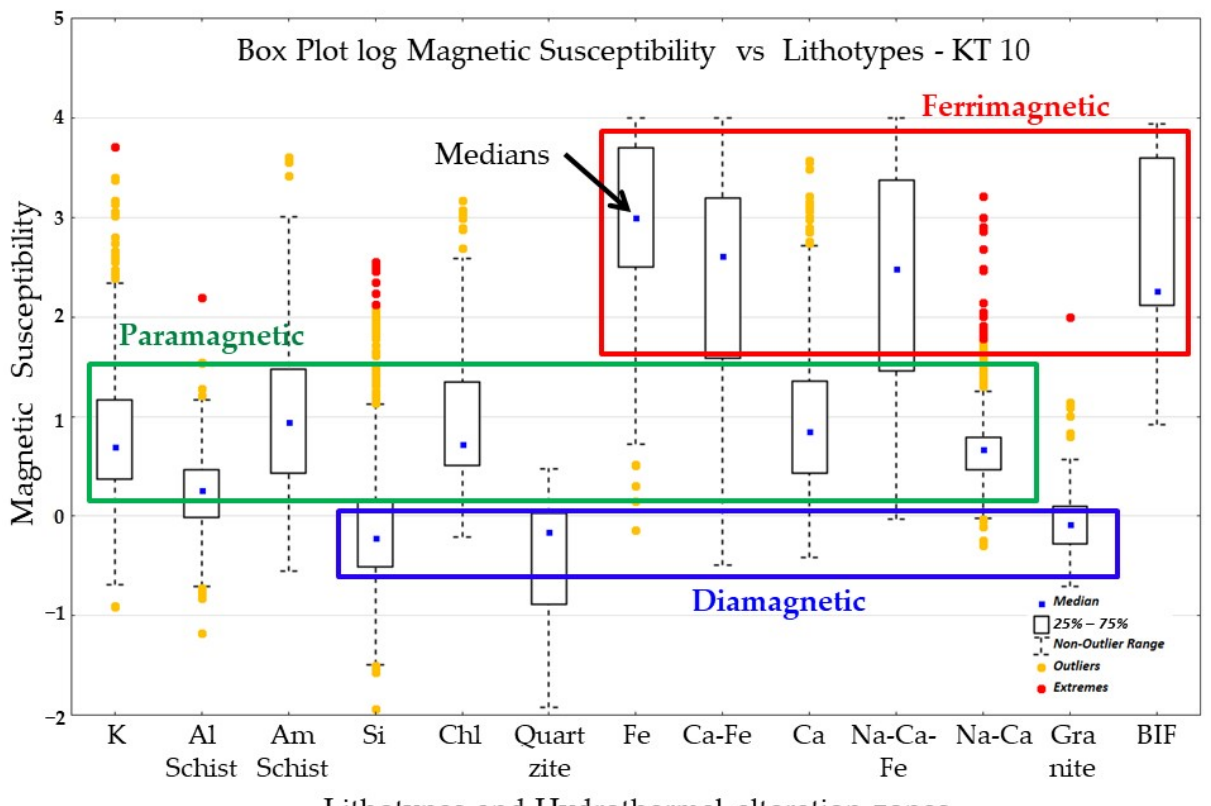
Figure 18. Box plot log of magnetic susceptibility (SI) versus lithotypes with values from the higher sensitivity susceptibility meter (KT-10). The ferrimagnetic, paramagnetic, and diamagnetic minerals dominances is represented in red, green, and blue rectangles, respectively. K = potassic, Al = aluminous, Am = amphibolitic, Si = silicification, Chl = chloritization, Fe = ferric, Ca = calcic, Na = sodic, BIF = banded iron formation.